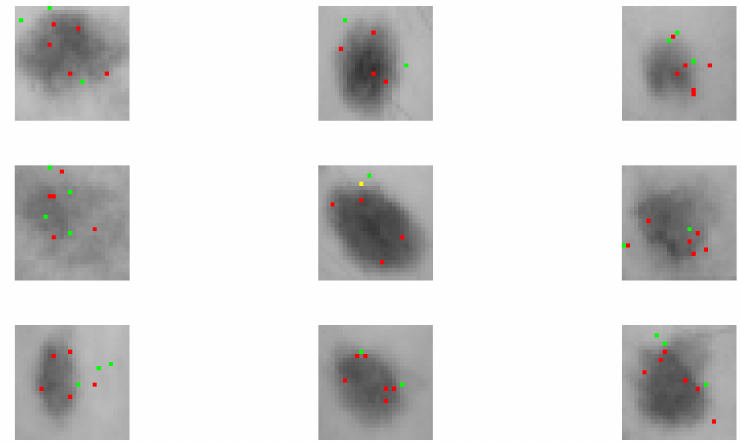
Figure 12. Centroids of nine rules with their antecedents generated from R 7 in the fully connected layers.